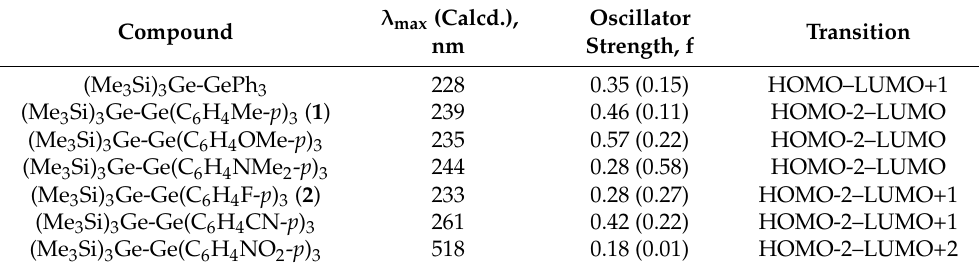
Theoretical analysis of UV/vis absorption spectral data for (Me 3 Si) 3 Ge-GeAr 3 (Table 1) shows a good correlation with the experiment (see Table 2 below). Table 2. Comparison of absorption maxima in UV/visible spectra for 1 – 3 and related